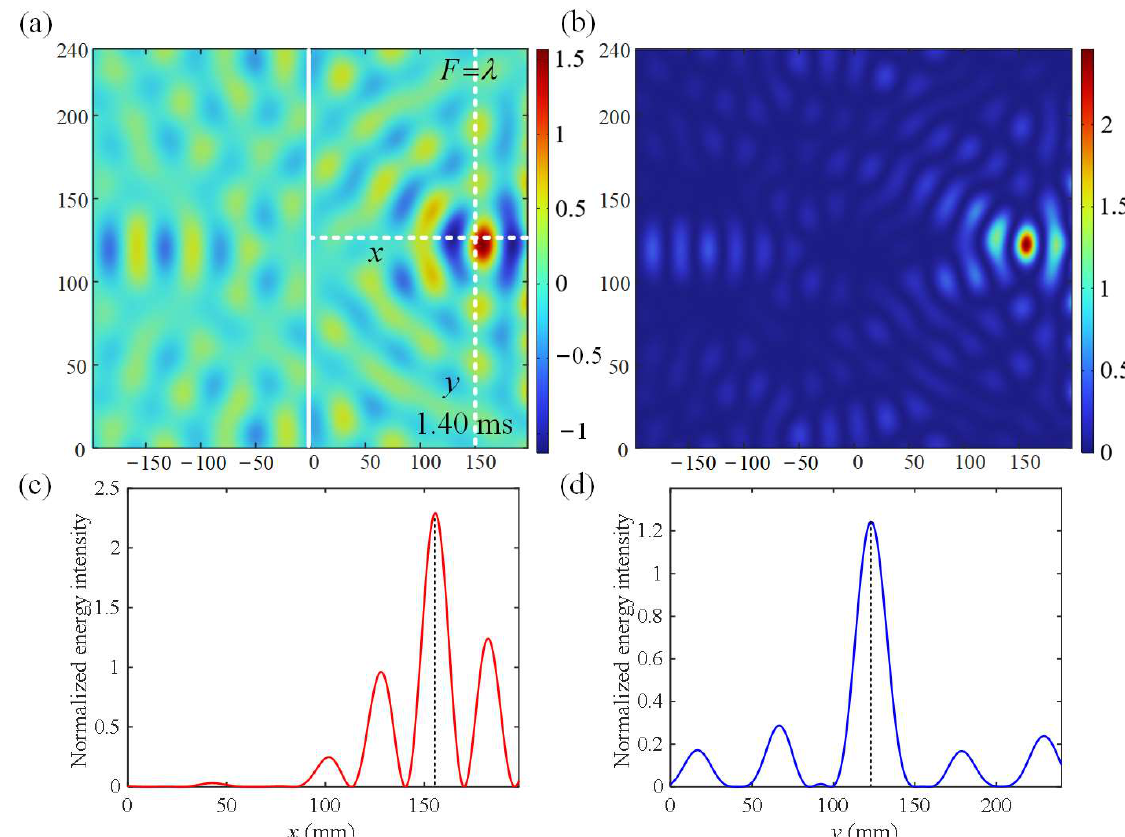
Figure 8. Numerical simulation results of ( a ) the reflected flexural wave field, ( b ) the normalized energy intensity field, and ( c , d ) the corresponding normalized energy intensity distribution along the white dashed line when the focal distance is λ